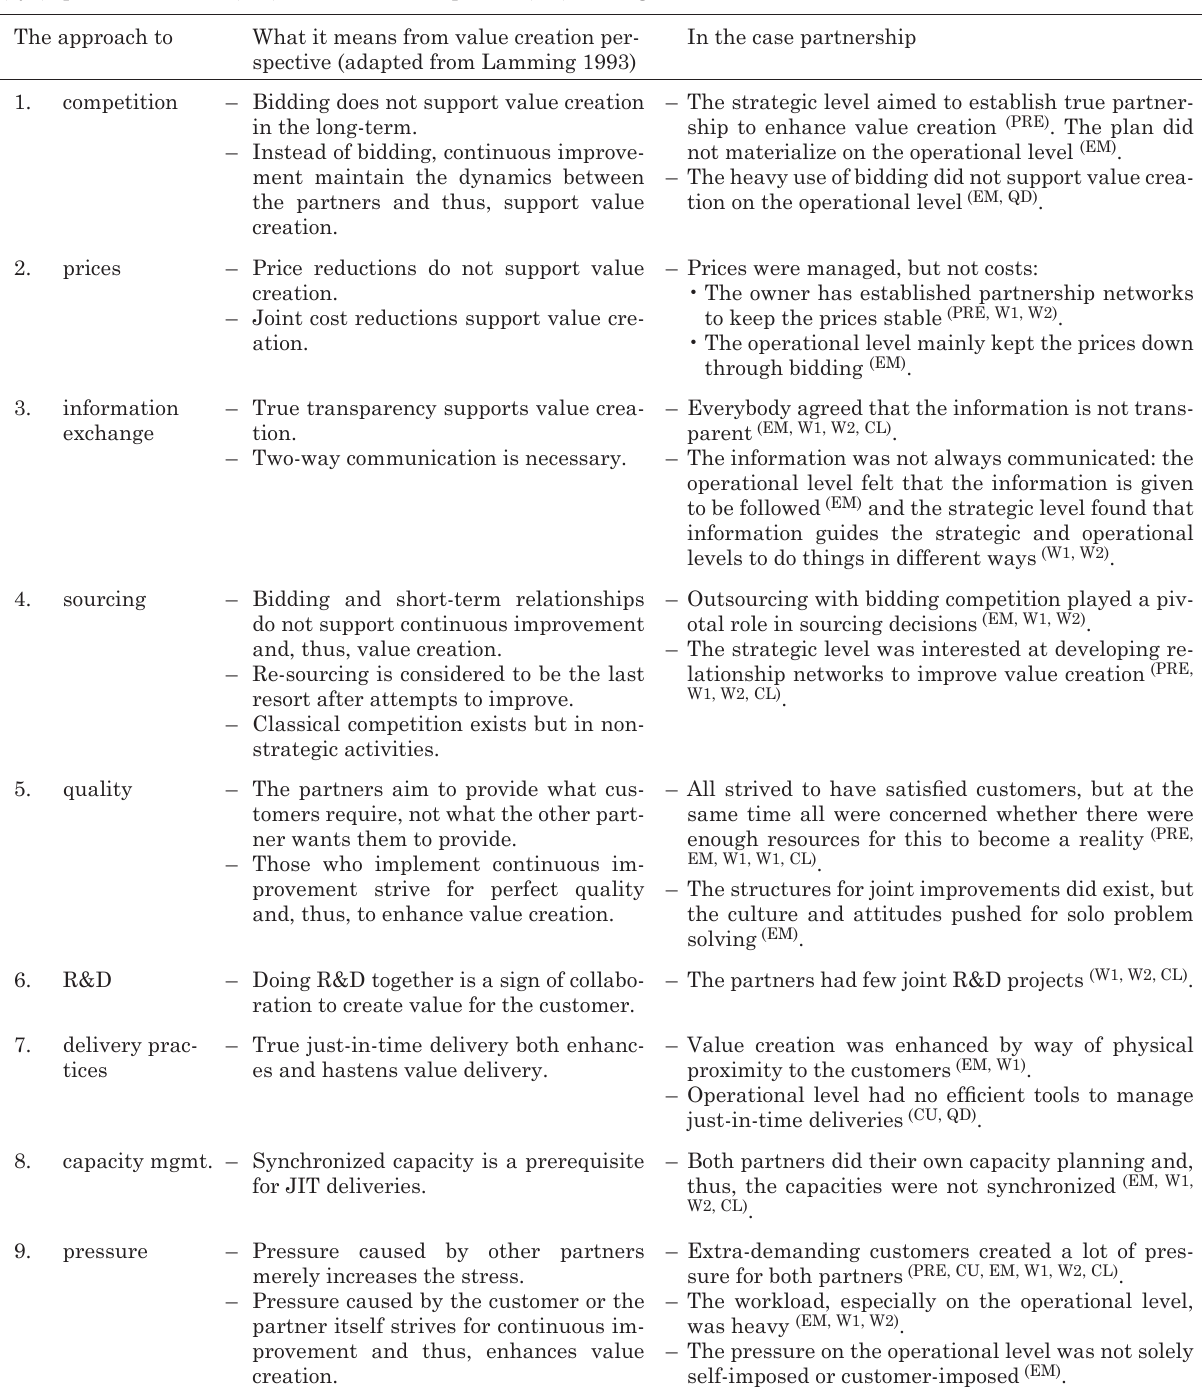
Table 2. The relationship factors in the case partnership from a value creation perspective and the sources of the results: (PRE) preliminary interviews, (CU) customer interviews, (EM) employee interviews, (W1) first workshop, (QD) quantitive data, (W2) second workshop, and (CL) closing interviews The approach to The strategic level aimed to establish true partner- ship to enhance value creation (PRE) . The plan did not materialize on the operational level (EM)